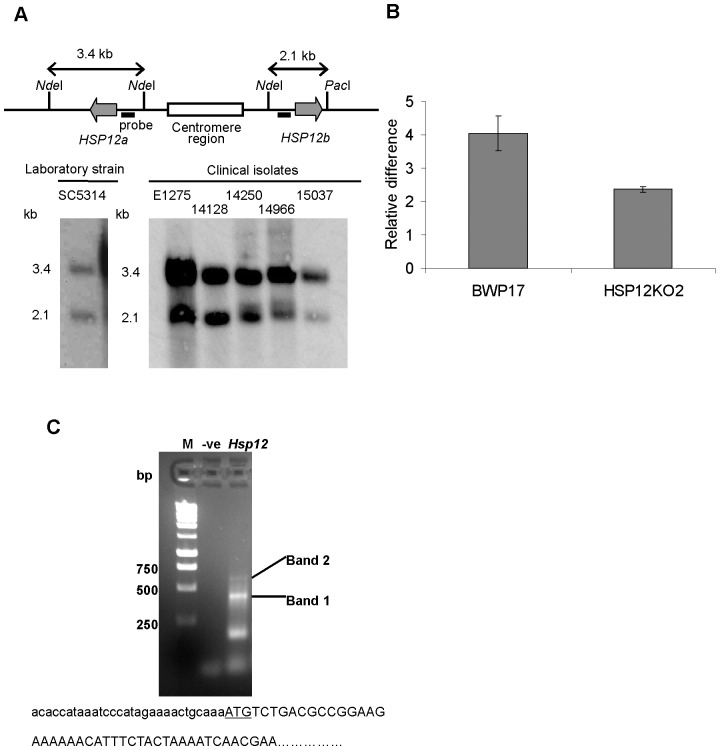

HSP12 differs among yeast species.(A) Two CaHSP12 genes have been identified in C. albicans SC5314 and five clinical isolates by Southern blot. (B) Both alleles of CaHSP12 are transcriptionally expressed. The transcription level of CaHSP12 is assessed by qRT-PCR of total RNA obtained from the strain with absence of one CaHSP12 gene (HSP12KO2) and its parental strain (BWP17). The error bars represent the S.D. of triplicate independent reactions. P value<0.01, two-sided unpaired student t-test. (C) 5′ RACE analysis of CaHSP12. Two DNA bands (band 1 and band 2) with the expected size above 250 bp were sequenced. The sequencing shows that the 5′ untranslated region (in lowercase) contains 29 bp nucleotides and only the second start codon (underlined) of CaHSP12 can be identified. M: 1 kb DNA ladder; -ve: negative control of PCR without template; HSP12: 5′RLM-RACE PCR product of CaHSP12.